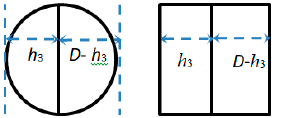
Table 2. Extreme 3: numerical simulation results of different material thicknesses.